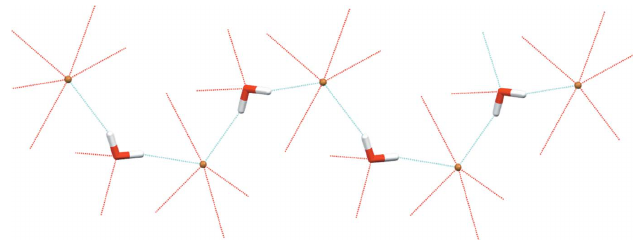
Figure 3 Zigzag chain of water molecules and bromide anions parallel to the b axis.